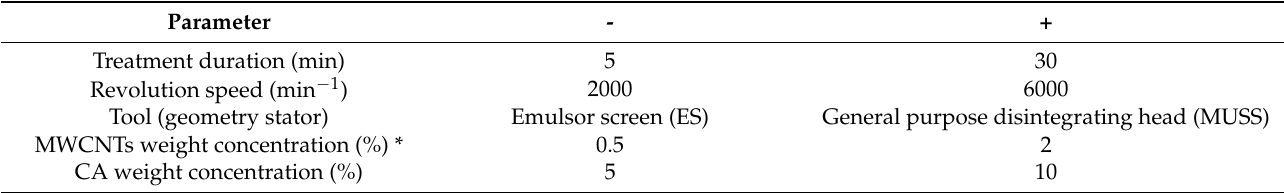
Table 1. Parameters of rotor-stator (RS) system.